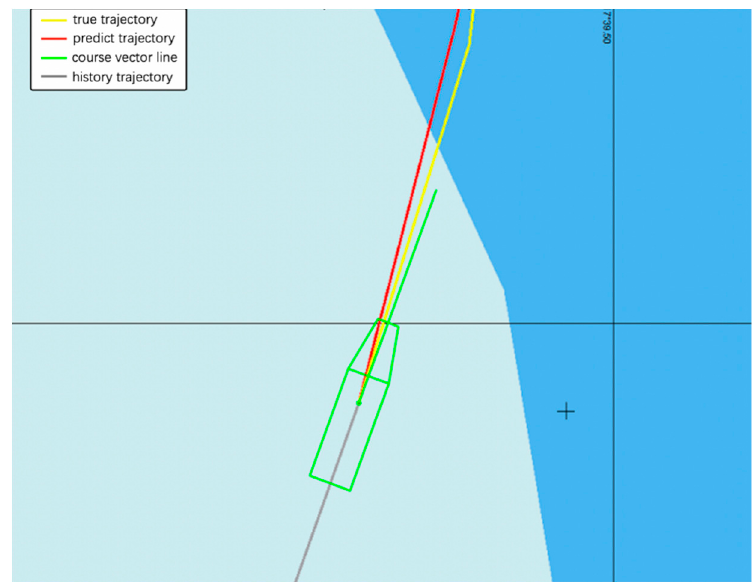
Figure 19. Visualization of the vessel’s real trajectory and predicted trajectory that uses the GRU model.